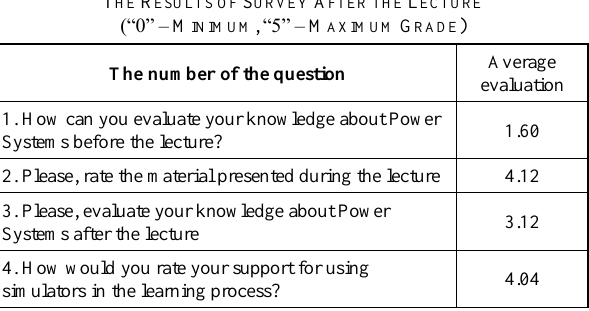
The number of the question